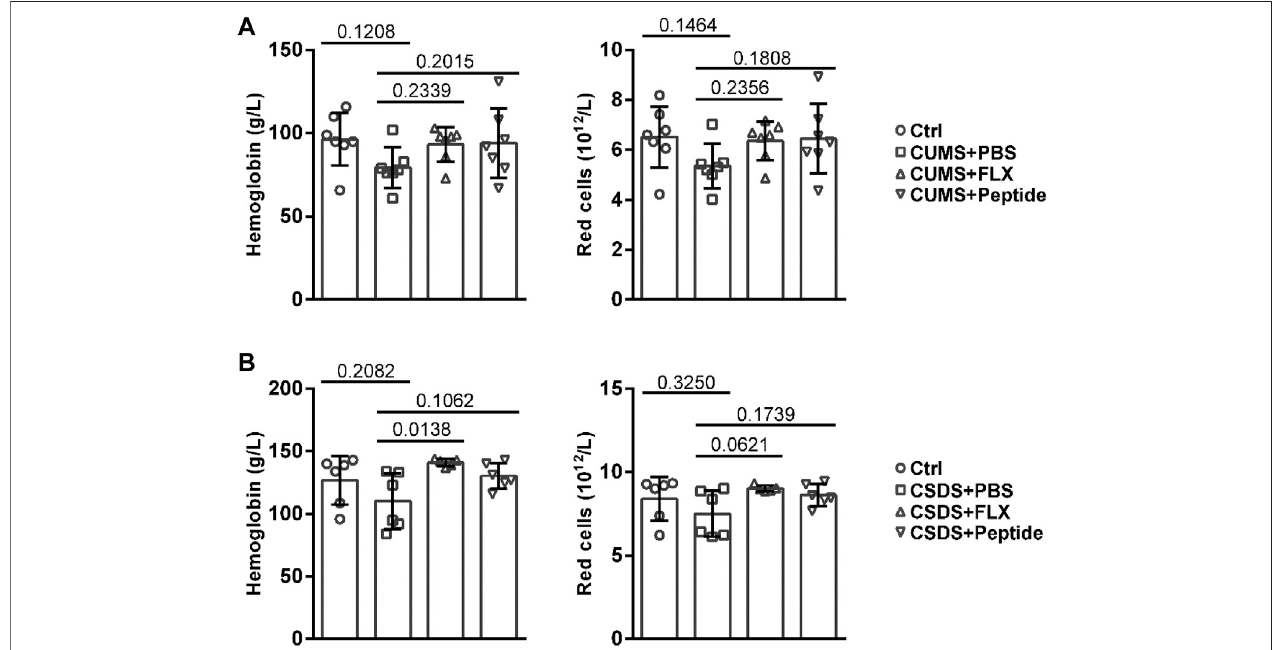
FIGURE 2 | ARA290 exhibited marginal effects on peripheral blood hemoglobin and red cells in the CUMS and CSDS mouse models: 8-week-old male C57BL/ 6micesubjectedtotheCUMSmodel( n =7micepergroup) (A) or5-week-oldmaleC57BL/6micesubjectedtotheCSDSmodel( n =6micepergroup) (B) weretreated with fl uoxetine (FLX) or ARA290 (peptide) daily. The levels of hemoglobin and red cells in the peripheral blood were then measured. Please note that one sample in the CSDS + FLX group accidentally underwent coagulation. The statistical values between different groups are shown.